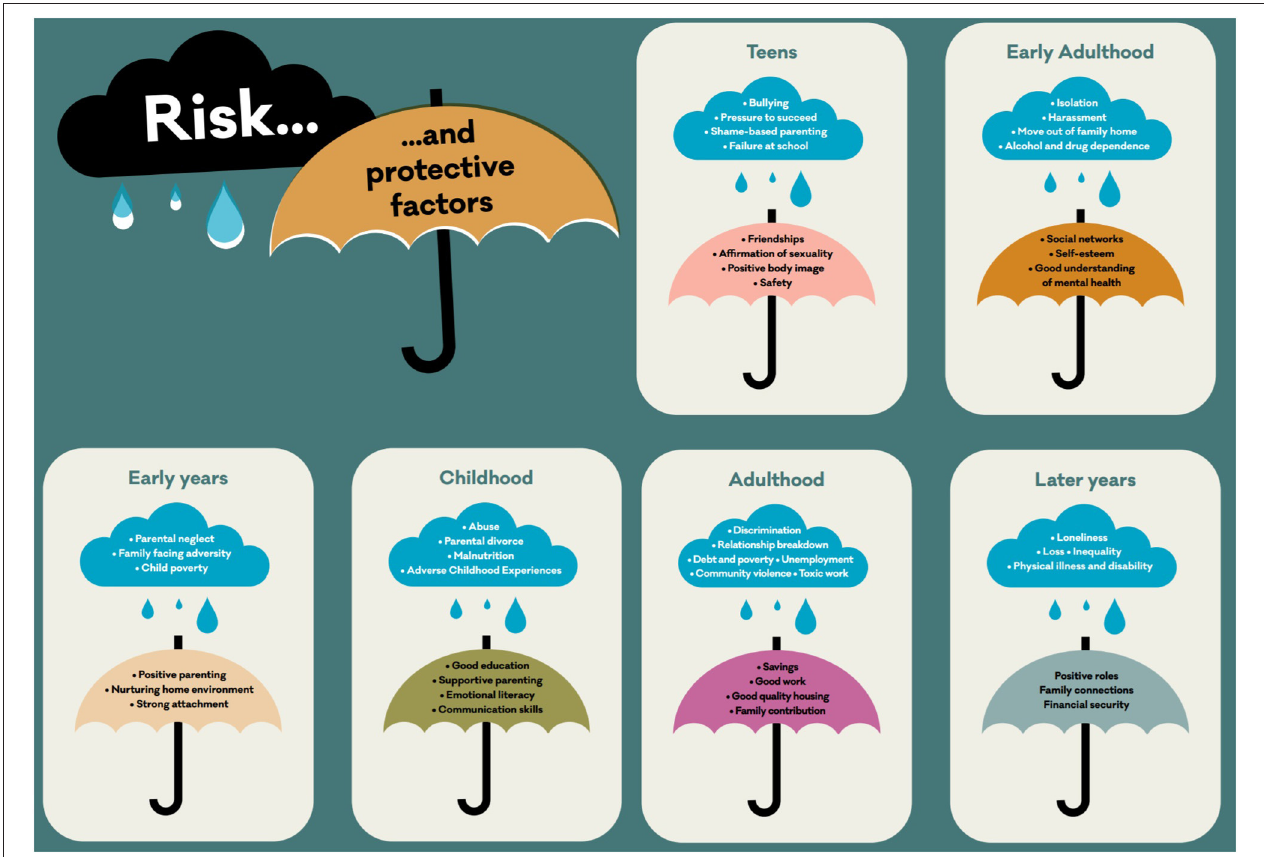
FIGURE 1 | Visualization of some indicative risk and protective factors across various stages of the course of life. (c) Kousoulis, Mental Health